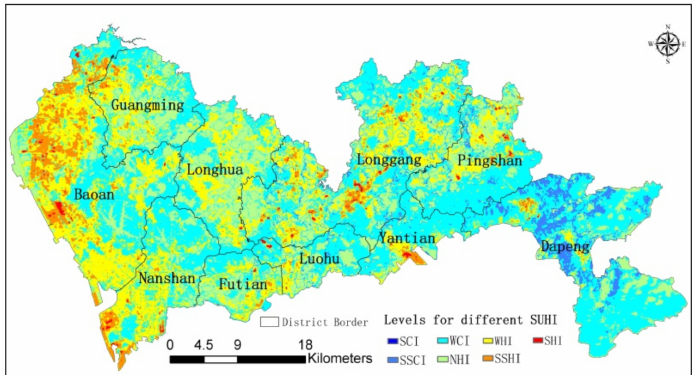
Figure 7. SUHI grades on 9 August 2013.